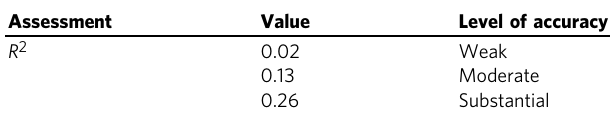
Table 4 Level of accuracy as suggested by Cohen (1988).